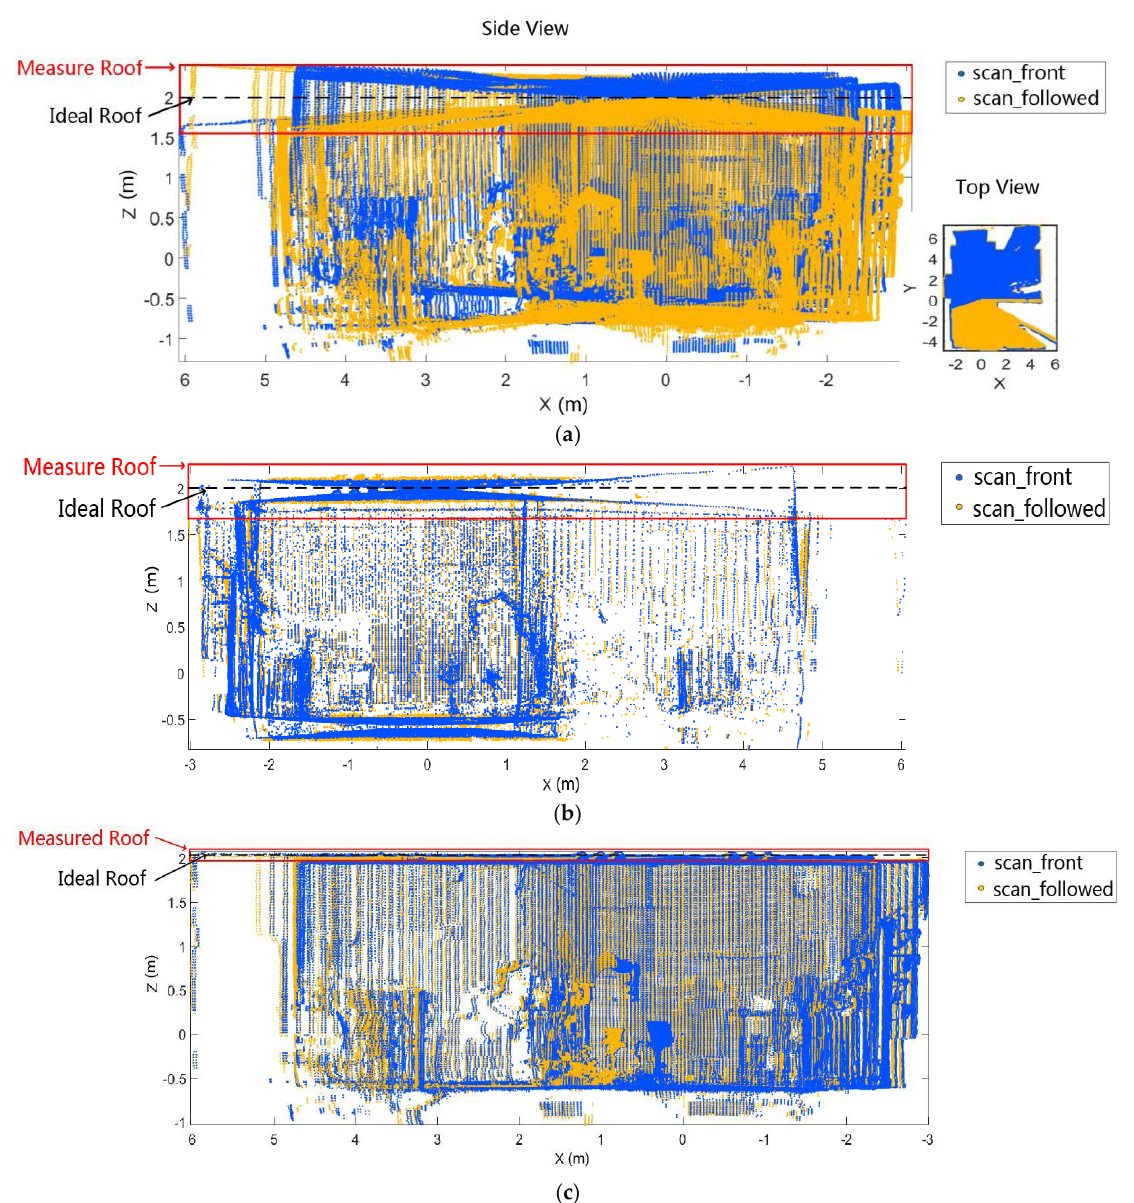
Figure 10. ( a ) is the full scan captured by our R2D-LIDAR system with a large deviation. The full scan contains two coincident scans of the point clouds marked by blue and yellow; ( b ) is the calibration result using Alismail’s method. Alismail’s method is effective in the two coincident scans matching but fails in bias adjustment, which is reflected in the roof; ( c ) is the calibration result employing both bias adjustment of the 2D LIDAR and Alismail’s method. The performance demonstrates the superiority of our improved calibrating method compared with Alismail’s method.